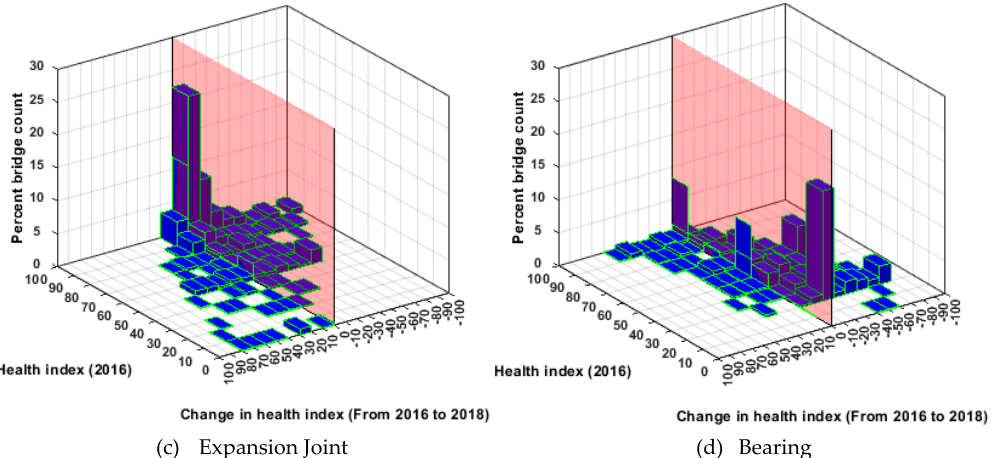
Figure 8. NHS bridge performance in Virginia. ( a ) Overall bridge; ( b ) concrete deck; ( c ) expansion joint; ( d ) bearing.